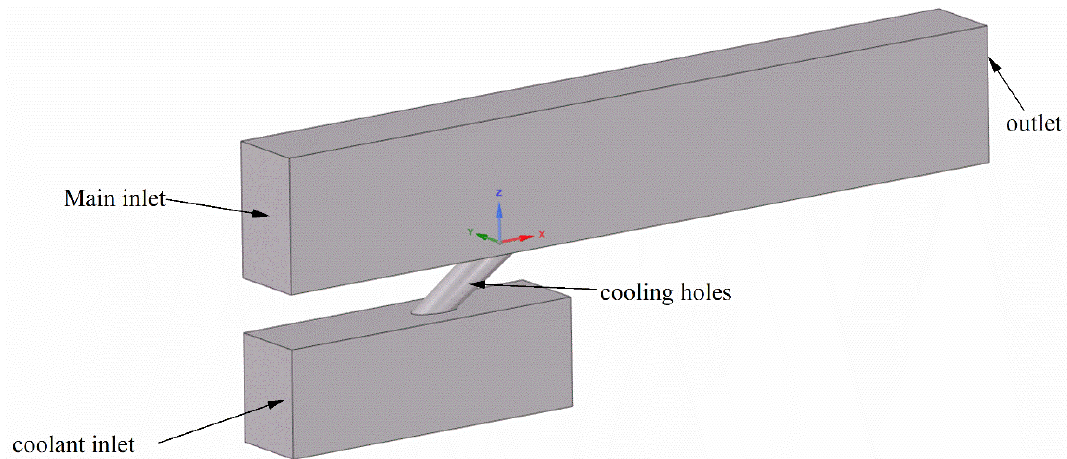
Figure 1. Schematic representation of cooling hole calculation domain.